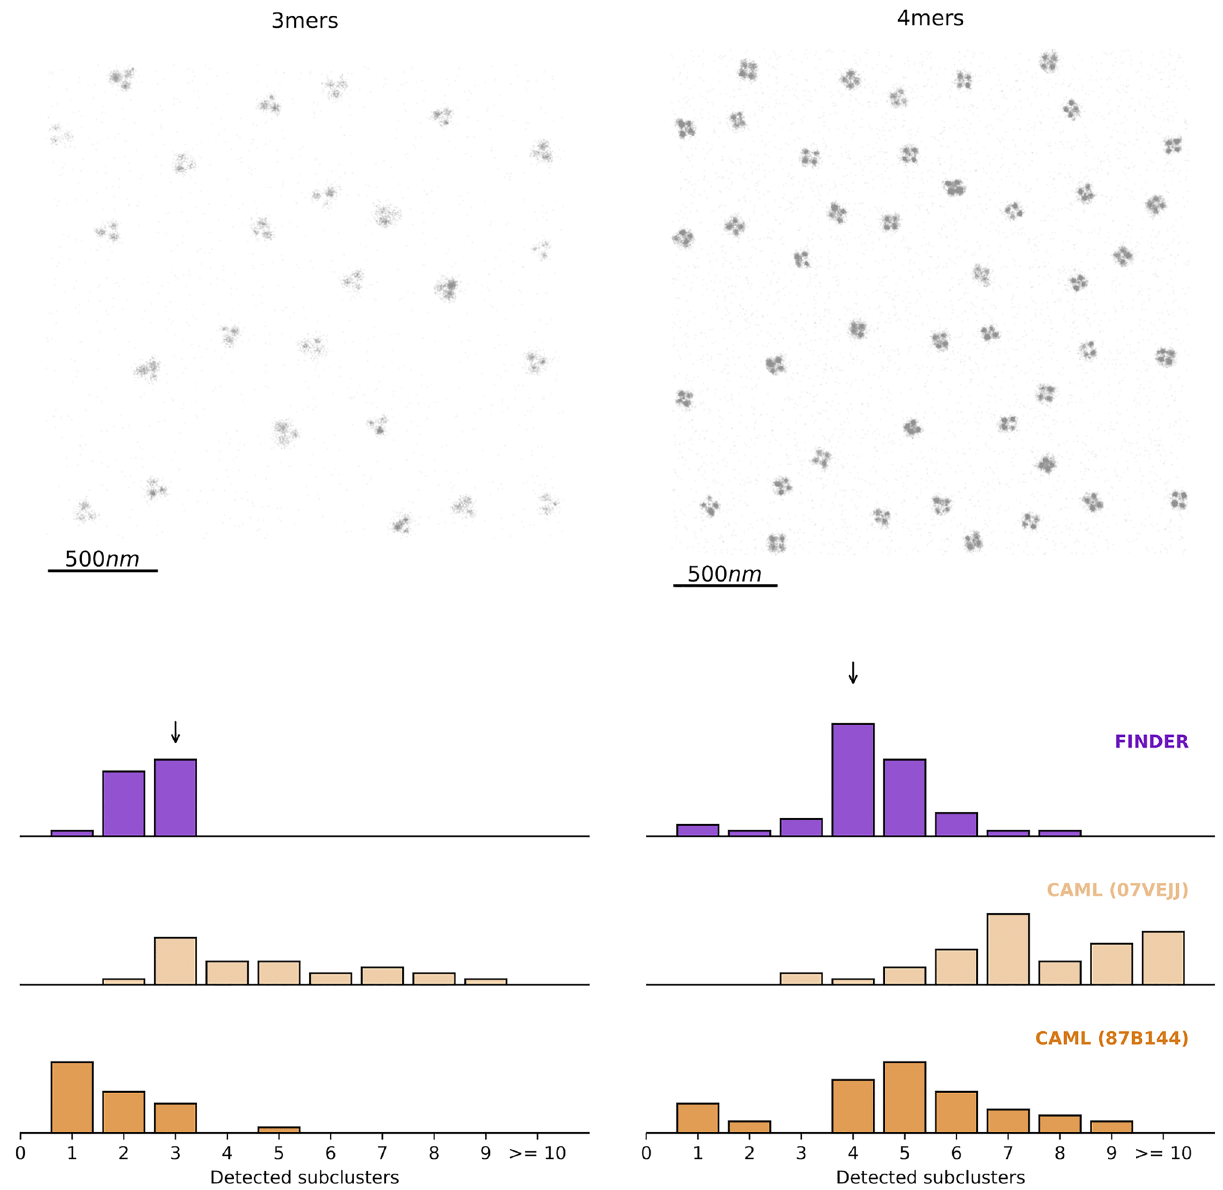
Figure 3. Performance of clustering algorithms for an image composed of 25 DNA-Origami 3-mers (left) and 44 4-mers (right), with added random noise localizations ( 10% of cluster localizations). The optimal radial parameters identified by FINDER for DBSCAN (noisefree) are ε = 8.05 nm and minPts = 9 (3-mers), and ε = 3.61 nm and minPts = 8 (4-mers). The histograms show the distribution of the number of subclusters detected for each 3-mer and 4-mer in our test data set, respectively. See Fig. S5 for clustering results without added noise, leading to a segmentation failure of CAML 87B144, suggesting that retraining is